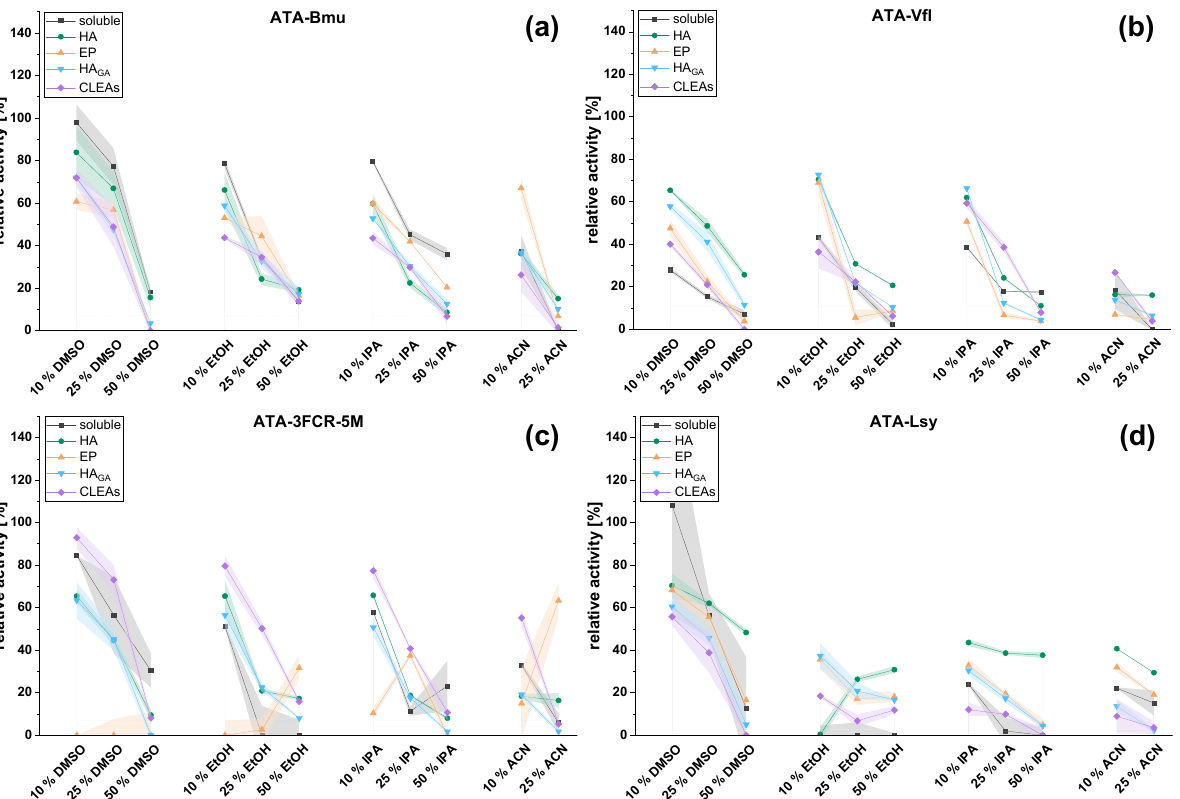
Figure 2. Operational solvent stabilities of different transaminases. Several solvents (DMSO, ethanol (EtOH), isopropanol (IPA), and acetonitrile (ACN)) were added in different concentrations (10, 25, and 50%) to the standard reaction solution (see below) of all transaminases and immobilizates: ( a ) ATA-Bmu, ( b ) ATA-Vfl, ( c ) ATA-3FCR-5M, and ( d ) ATA-Lsy. The activity without additives (standard reaction solution for all ATAs: 50 mM Tris pH 8.0, 0.5% DMSO, 0.1 mM PLP, 2.5 mM rac -1-PEA, and 2.5 mM pyruvate) was set as 100%, and the standard deviation of duplicates is shown as filled area.